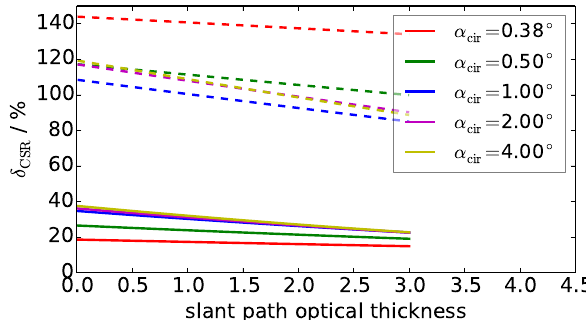
Fig. 4. Relative uncertainty δ CSR for certain fields of view (legend gives opening half-angle in degrees). Solid lines: for r eff = 25 µm and undefined ice particle shape. Dashed lines: for undefined r eff and ice particle